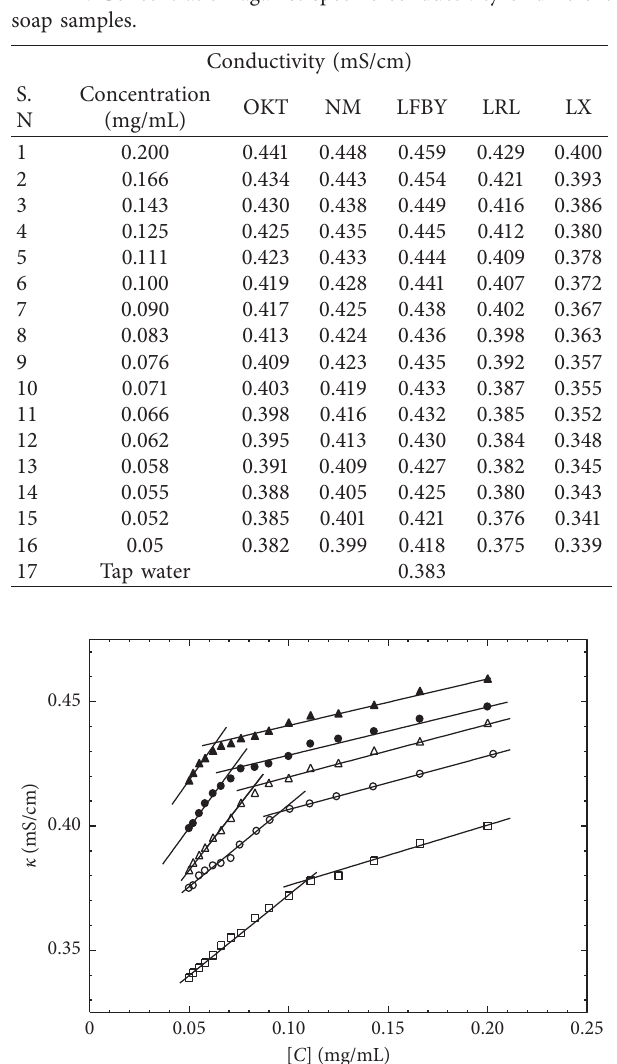
Figure 1: Graph depicting the variation of specific conductance with the concentration of different soaps: LFBY (closed triangles), NM (closed circles), OKT (triangles), LRL (circles), and LX